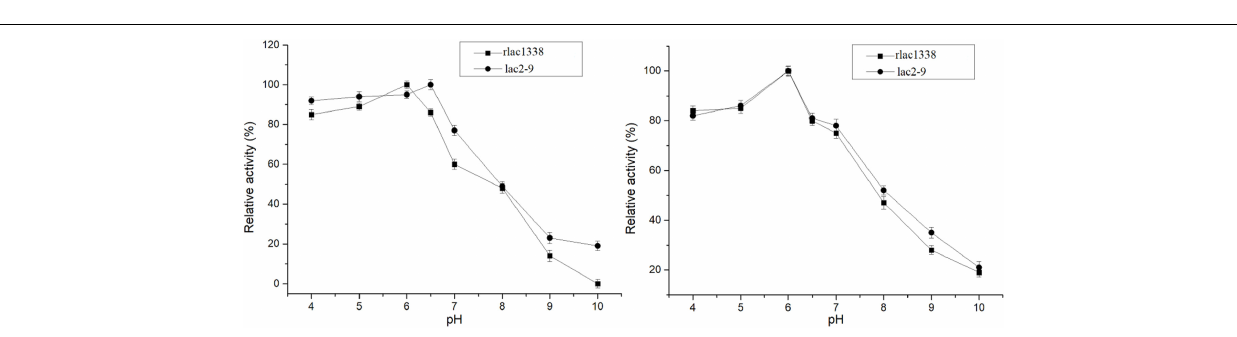
FIGURE 3 | Comparison of optimal pH and pH stability of mutant strain lac2-9 and recombinant rlac1338. TABLE 2 | Comparison of kinetic parameters and enzyme activity between mutant enzyme lac2-9 and rlac1338. Enzyme Substrate K m ( µ M) k cat (s − 1 ) k cat /K m (s − 1 µ M − 1 ) Specific enzyme activity (U/mg) rlac1338 2,6-DMP 654 ± 2 . 1 9 . 43 ± 0 . 8 1.44 × 10 − 2 1 . 12 ± 0 . 02 210 ± 3 .